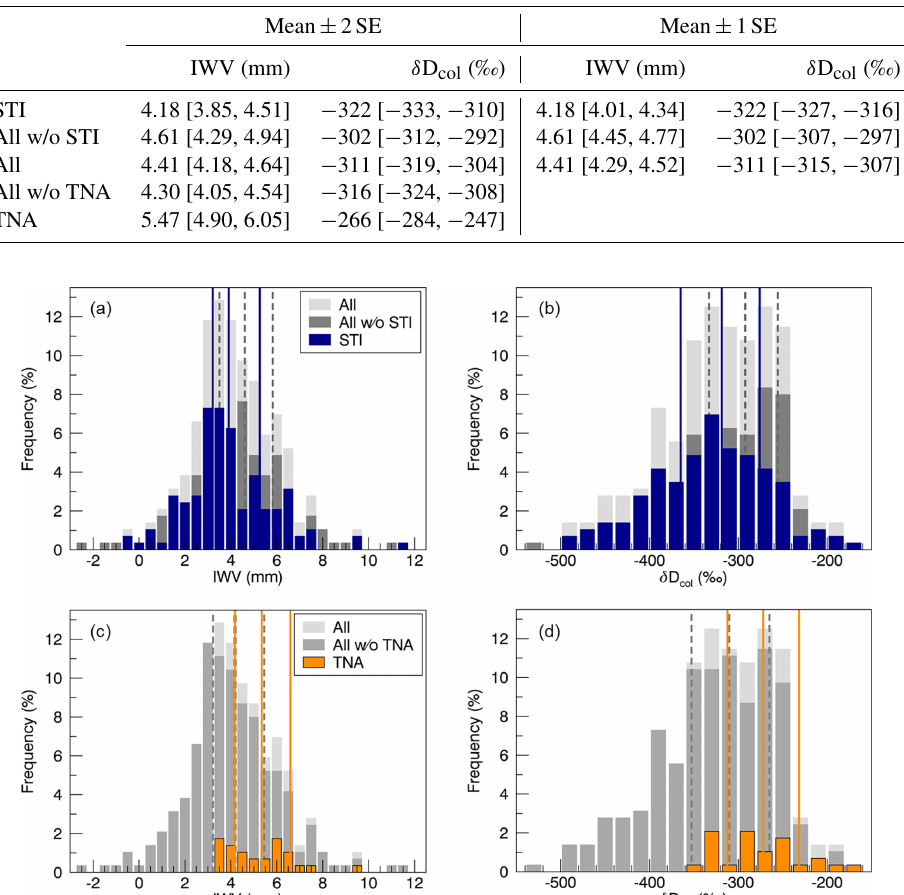
Table 3. Distributions of deseasonalized daily mean IWV and δ D col data (FTIR Zugspitze) for STI and TNA events identified from Garmisch lidar measurements in 2013–2015 given as mean ± 2SE (for STI, mean ± 1SE is also given).